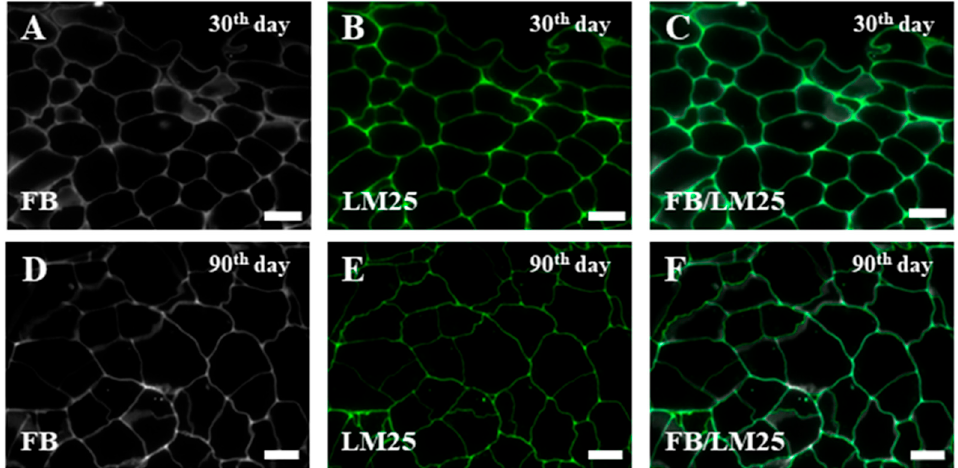
Figure A6. Immunolocalisation of LM25 ( A – F ) in B. distachyon callus. ( A – C ) 30th day of cultivation; ( D – F ) 90th day of cultivation. Scale bars, 10 μ m.